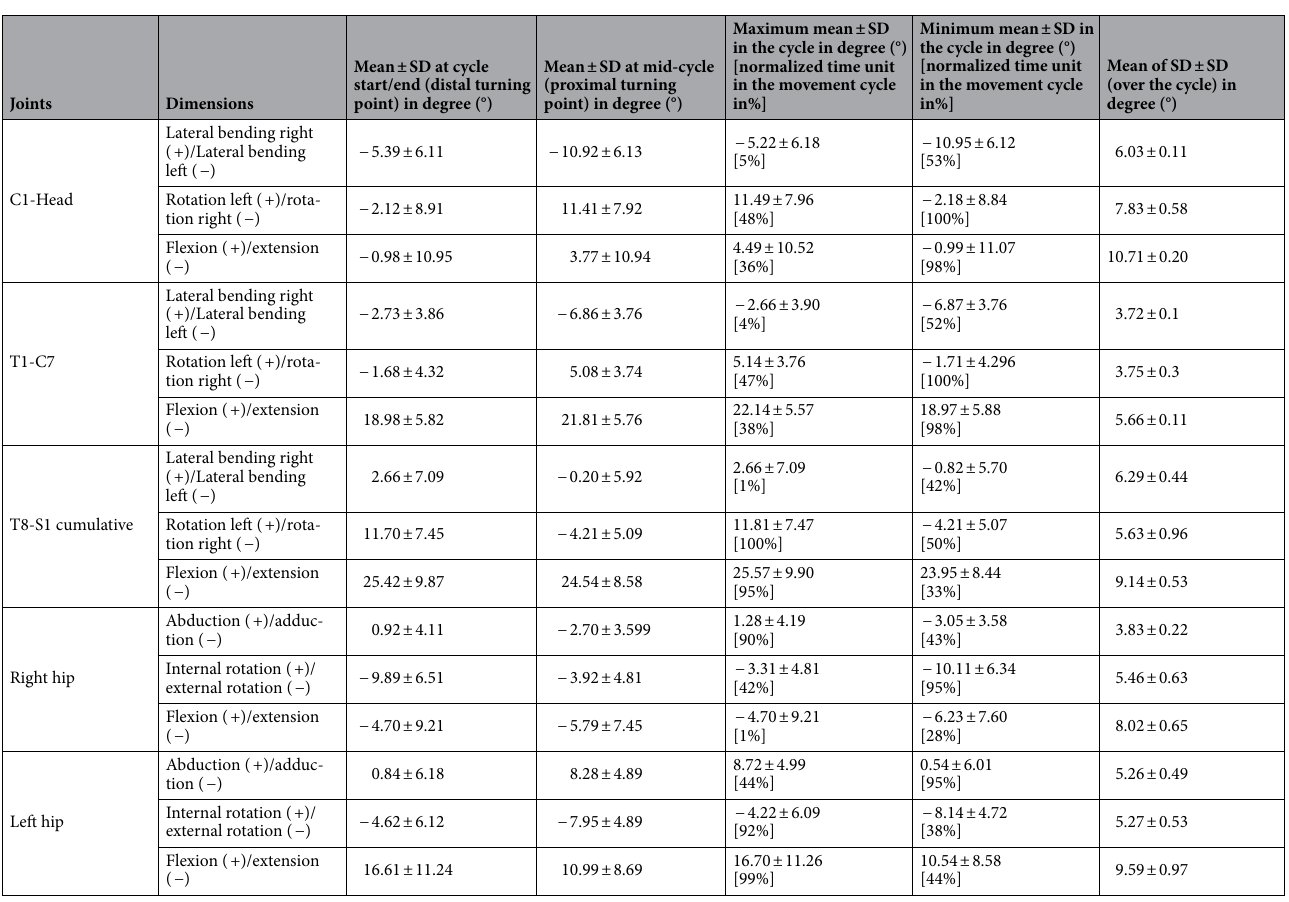
Table 2. Mean values and standard deviations (SD) of movements of C1-Head, T1-C7, T8-S1 cumulative, right and left hip over the course of the